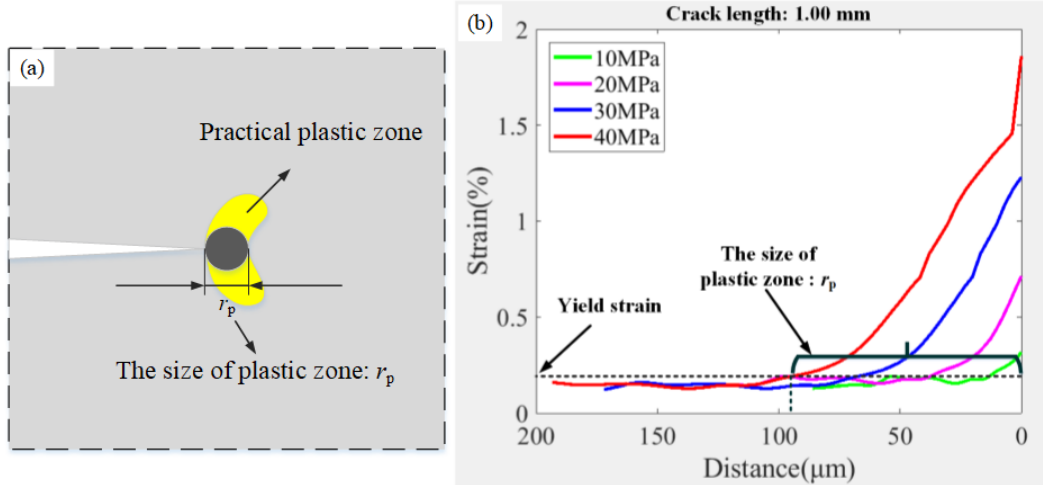
Figure 5. ( a ) Schematic illustration of the plastic zone ahead of the crack tip; ( b ) strain distribution along the crack plane under different loadings.